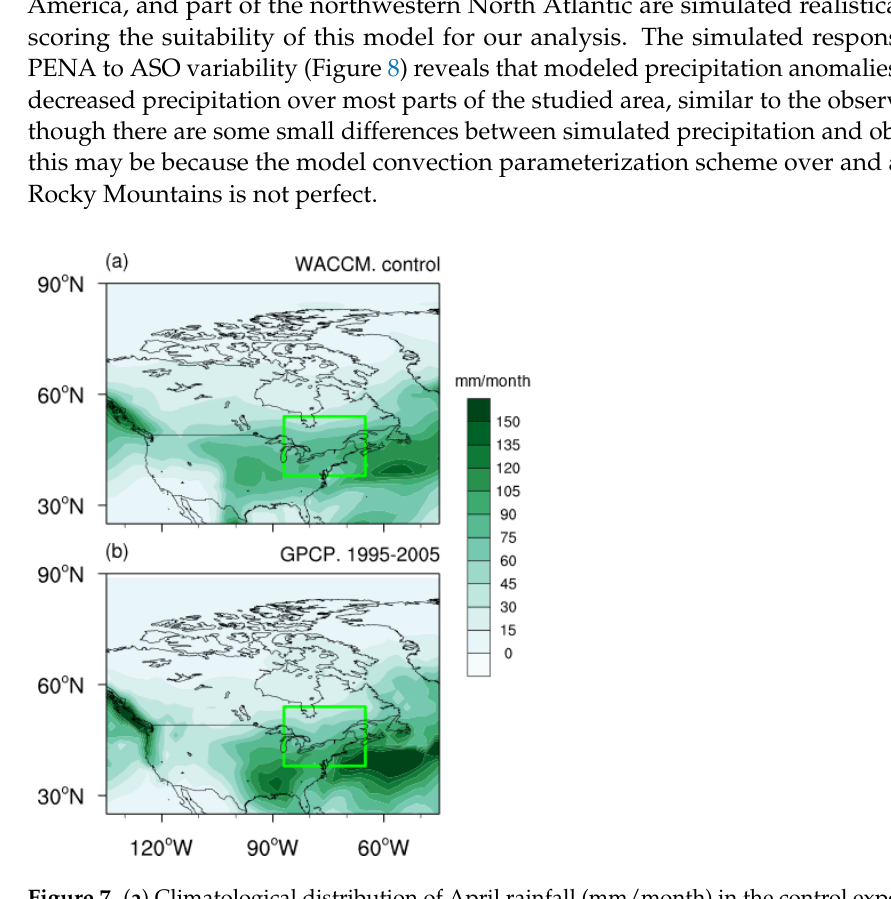
Figure 8. Differences in April precipitation between experiments E3 and E2 (mm/month). Cross-hatching denotes regions for which values are significant at the 90% confidence level. The simulated responses of water vapor flux and its divergence to ASO anomalies are displayed in Figure 9. Over eastern North America, the water vapor flux exhibits an anticyclonic behavior (Figure 9a) that is similar to the observed conditions (Figure 6a). Although the enhanced moisture divergence is also well simulated (Figure 9c), we note that the center of divergence is displaced slightly south of its observed position (Figure 6c). This offset potentially reflects limitations in the convective parameterization scheme employed in the model, as suggested by several previous studies [79 – 81], particularly in the vicinity of the Rocky Mountains. The model’s coarse resolution may further exacer- bate simulation inaccuracies.